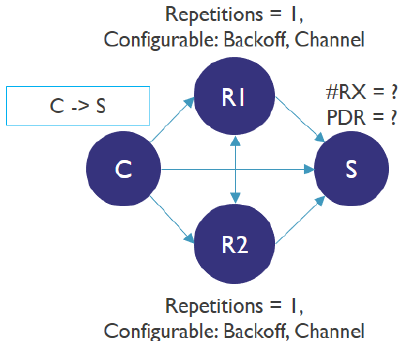
Figure 24. Network topology to test effect of variable backoff on PDR.